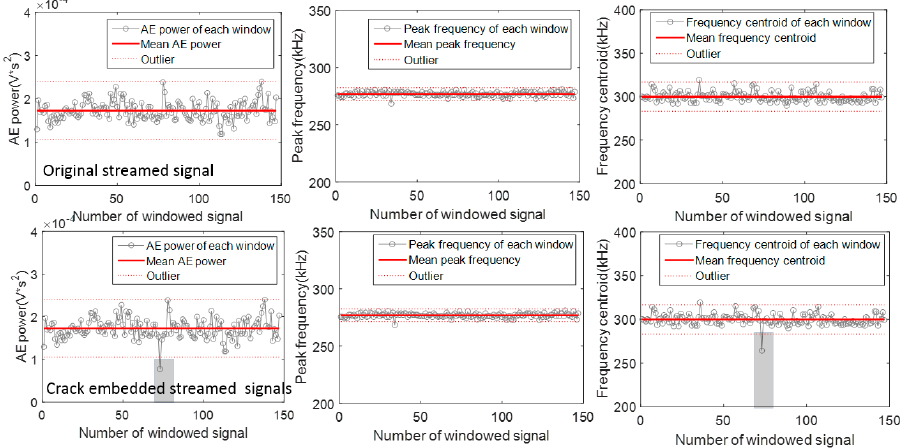
Figure 10. The outlier detection of AE power, peak frequency and frequency centroid of original streamed signal and embedded streamed signal ( SNR = 1.0, location of cracking signal: 74).